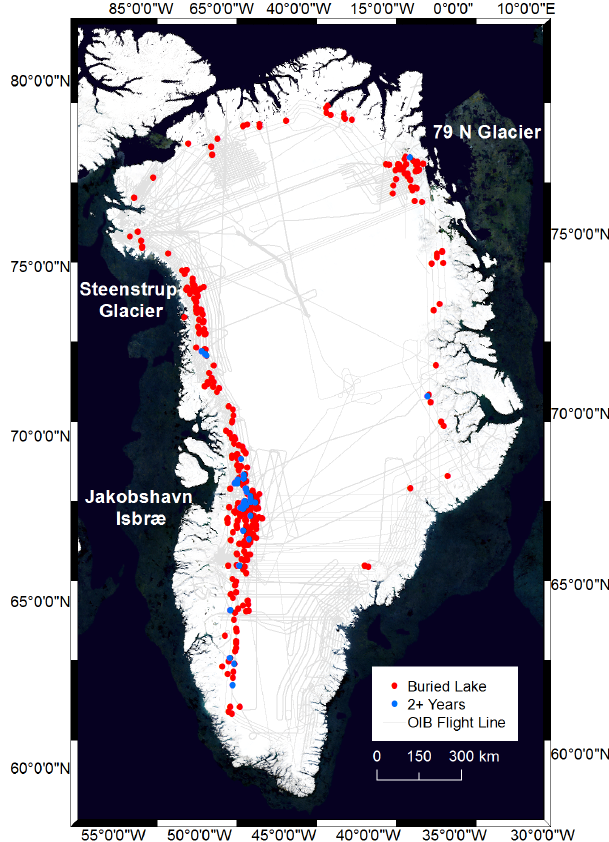
Figure 5. Locations of buried lakes (red circles) and multi-year buried lakes (blue circles) from 2009 to 2012 with OIB flight lines (gray